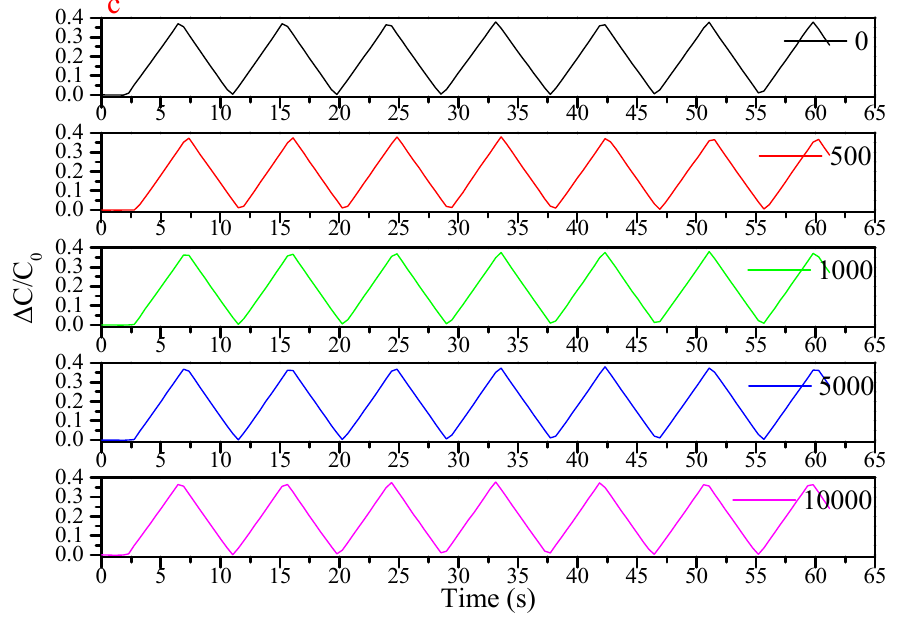
Figure 5. ( a ) Sensor record at the frequency of 0.5 Hz with 50% elongation at different times of the durability test. ( b ) At the frequency of 0.2 Hz with 50% elongation. ( c ) At the frequency of 0.1 Hz with 50% elongation.